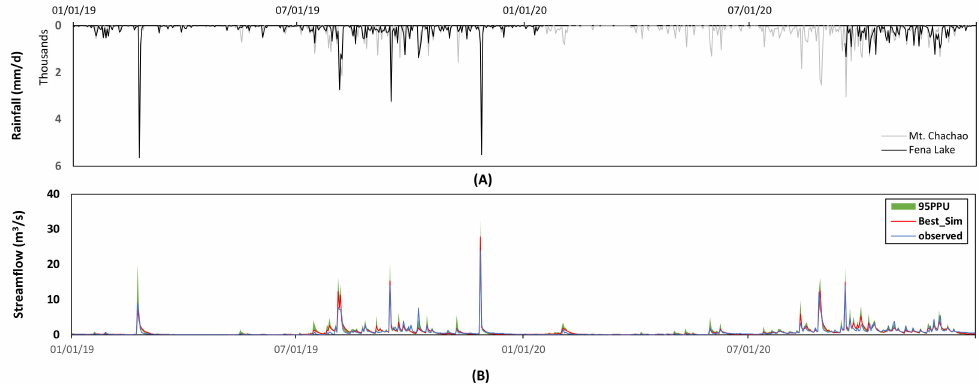
Figure 9. ( A ) Daily measured rainfall data sets from Mt. Chachao and Fena Lake rain gauge stations, and ( B ) observed, simulated daily streamflows, and the estimated 95% model uncertainty at USGS Pago River station (16,865,000) for the validation period (2019–2020).